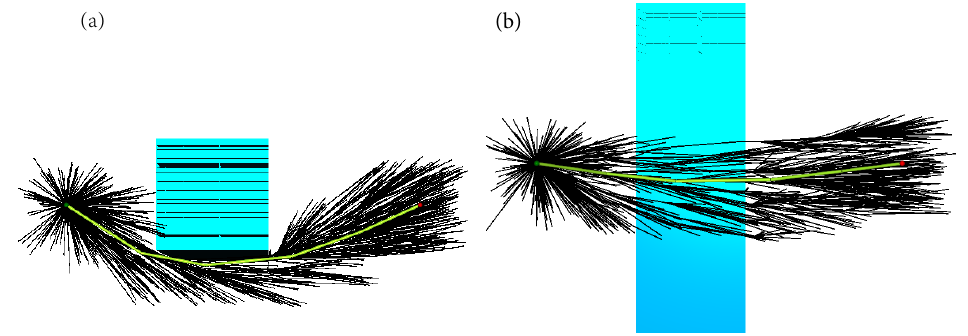
Figure 18. Example result of the improved FMT algorithm with large obstacle: first step number of samples = 1500, second step number of samples = 1000, computing time = 208.6 ms, error = 2%.The generated graph is drawn in black, the obstacle in blue, and the path (start point in green and end point in red) in green. ( a ) Top view; ( b ) side